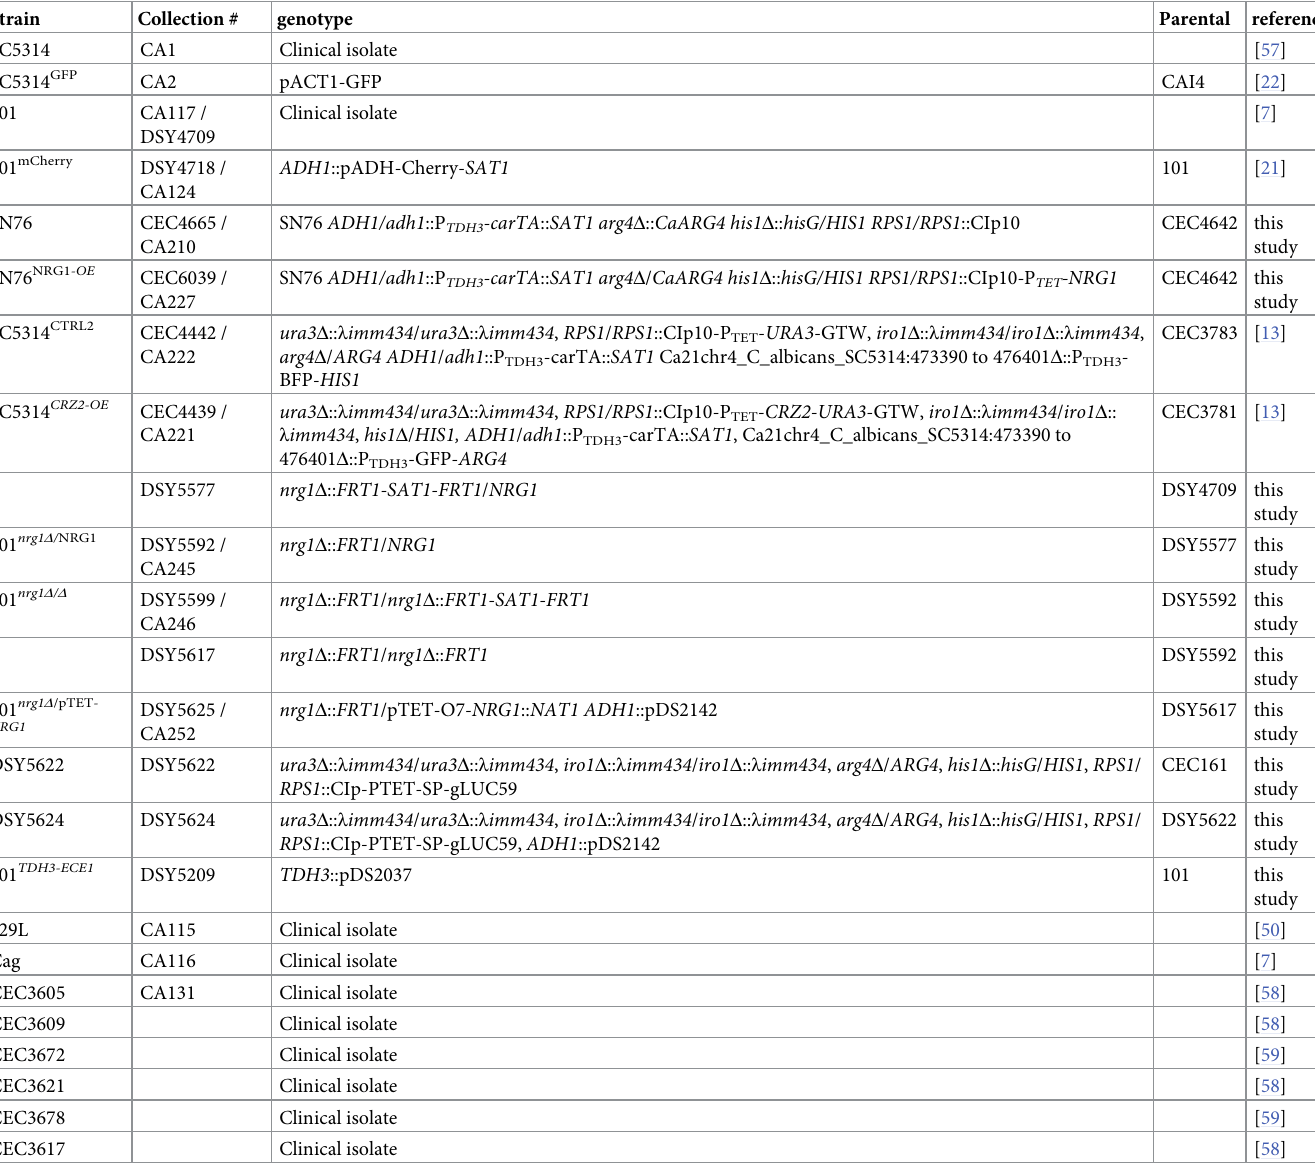
Table 1. C. albicans strains used in this